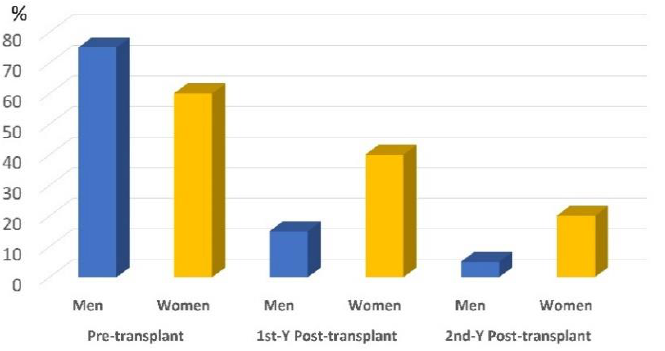
Figure 4. Prevalence of VD deficiency defined by 25OHVD < 25 nmol/L in men and women’s groups throughout the study period.